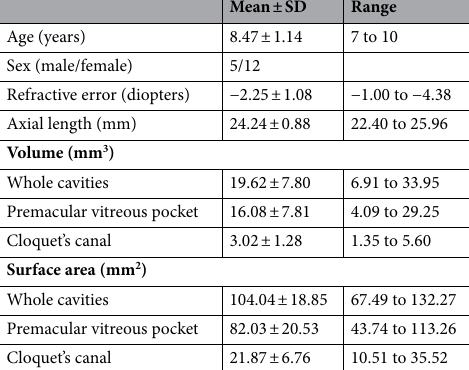
Table 1. Clinical variables and biometric data of school children. SD standard